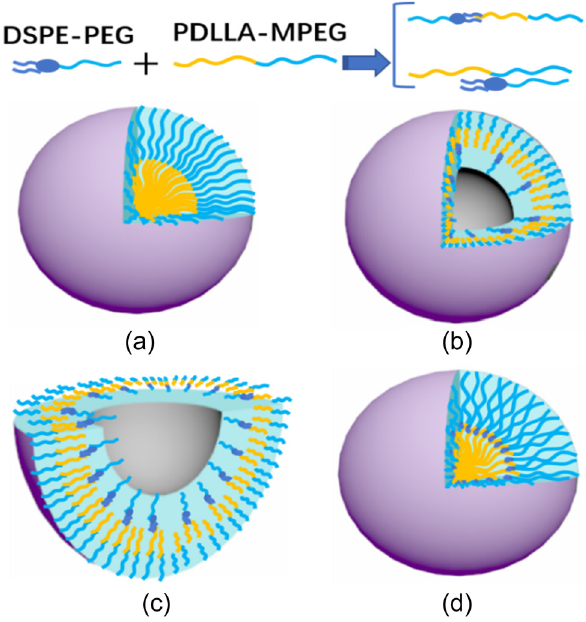
Figure 5: Schematic representation of the possible aggregate structures formed from DSPE – PEG2k/PDLLA – MPEG mixtures with increasing mass ratio: ( a ) pure micelles, ( b ) vesicles, ( c ) semi - vesicles and ( d ) mixed micelles.